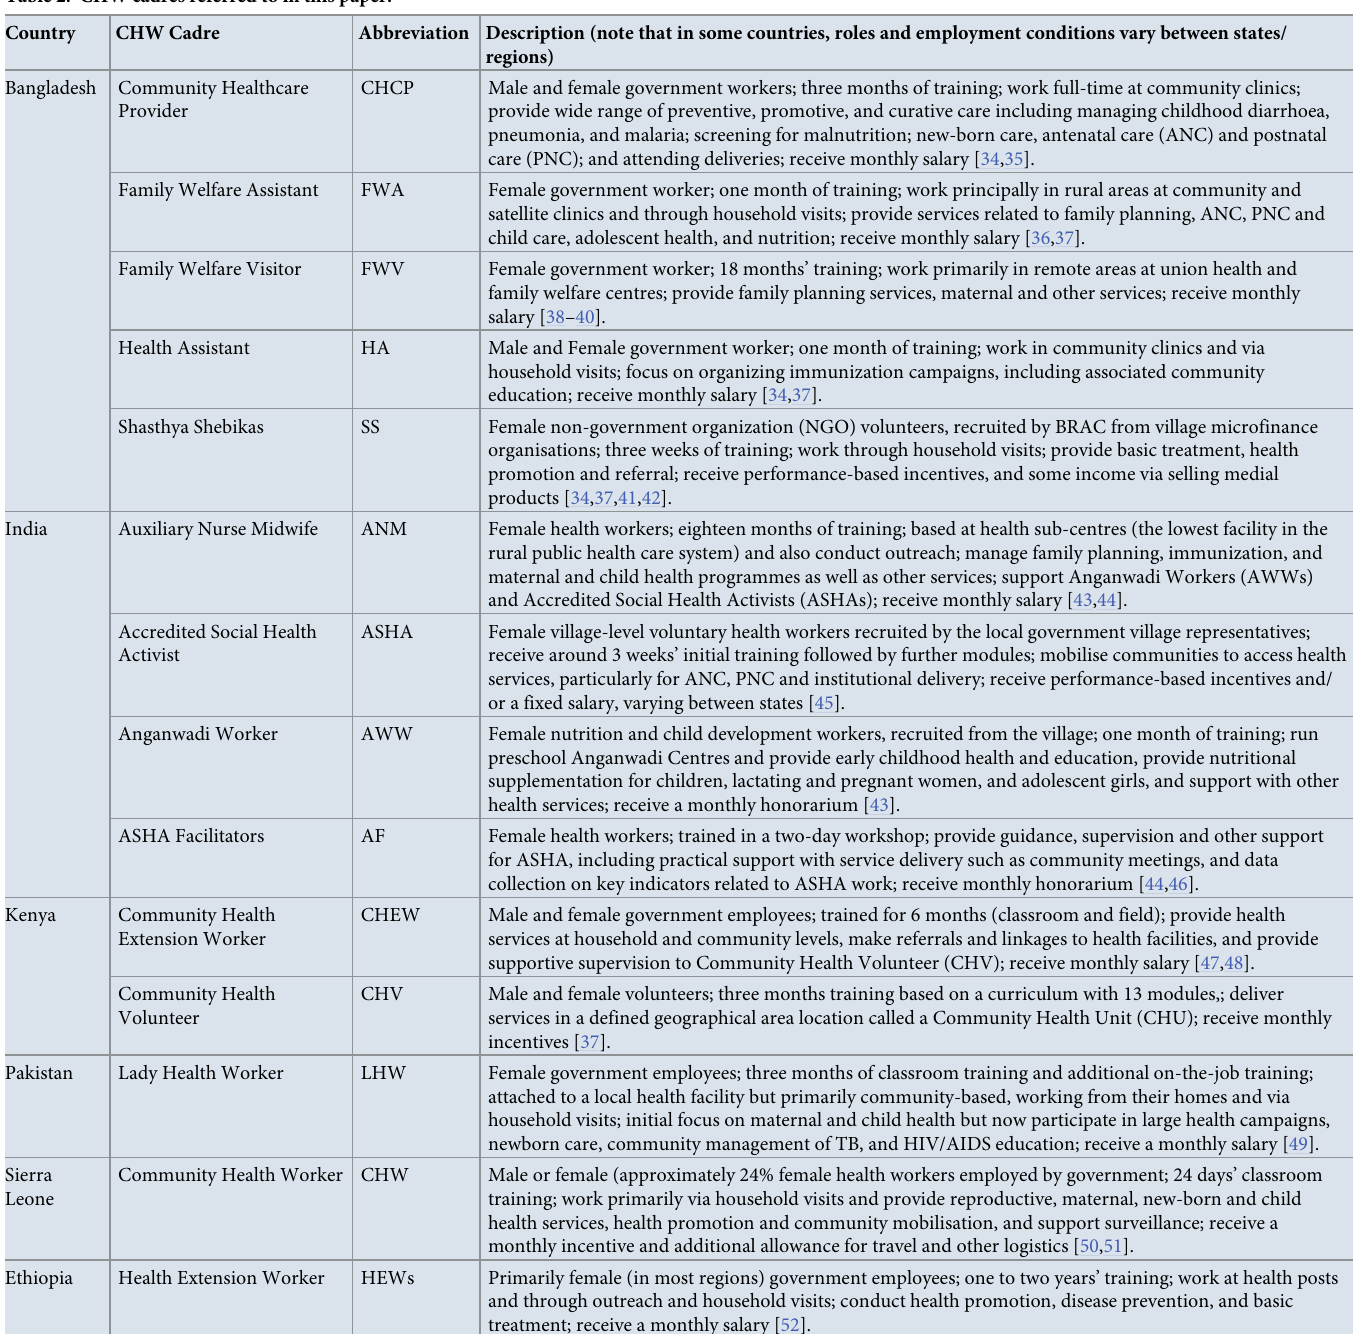
Table 2. CHW cadres referred to in this paper. Country CHW Cadre Abbreviation Description (note that in some countries, roles and employment conditions vary between states/ regions) Bangladesh Community Healthcare CHCP Male and female government workers; three months of training; work full-time at community clinics; Provider provide wide range of preventive, promotive, and curative care including managing childhood diarrhoea, pneumonia, and malaria; screening for malnutrition; new-born care, antenatal care (ANC) and postnatal care (PNC); and attending deliveries; receive monthly salary [34,35]. FWA Female government worker; one month of training; work principally in rural areas at community and satellite clinics and through household visits; provide services related to family planning, ANC, PNC and child care, adolescent health, and nutrition; receive monthly salary